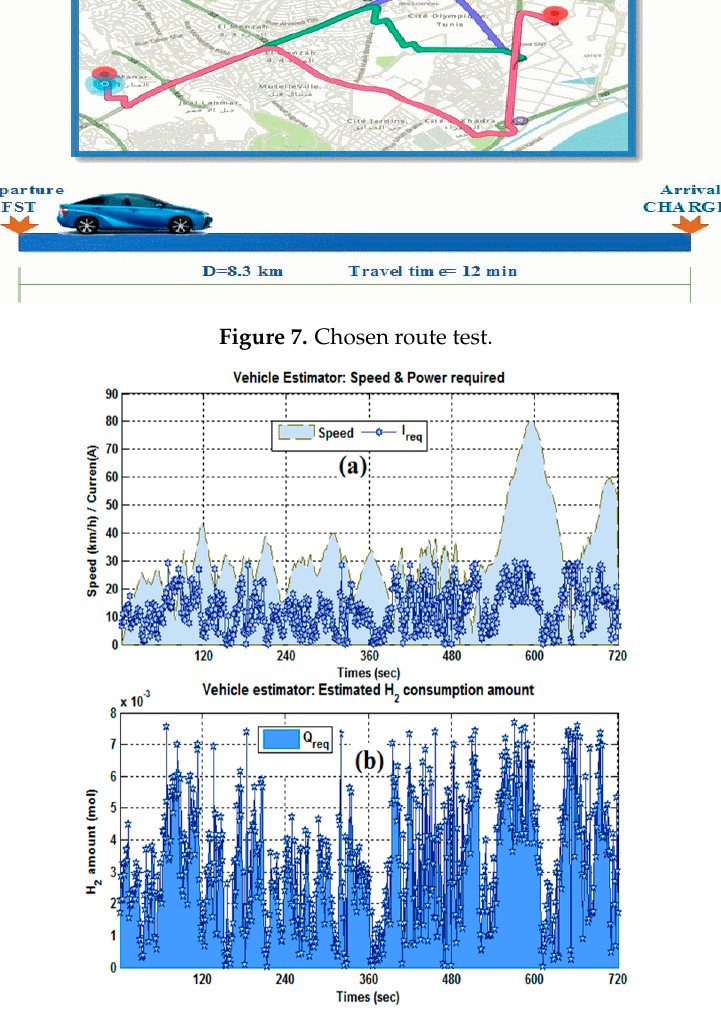
Figure 8. Vehicle estimator outputs: ( a ) speed estimation and ( b ) required H 2 amount.